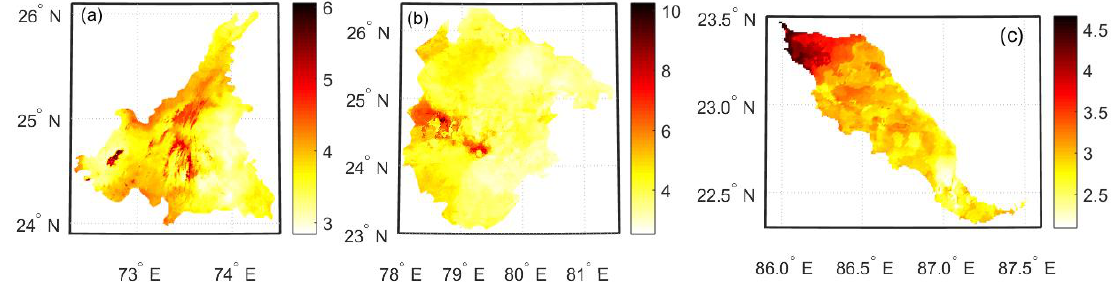
Figure 10. Frequency plots concerning the number of months of drought per year for all three study areas selected based on scPDSI ≤ −1.5 for each grid cell. ( a ) AV ( b ) BK ( c ) KSB. The scale bar represents the number of